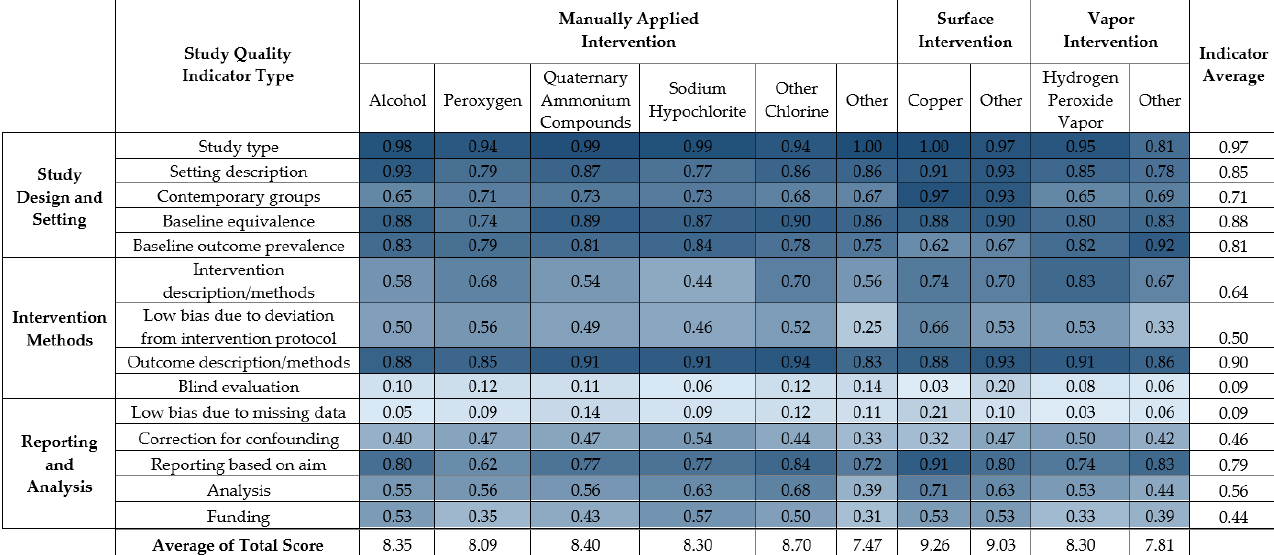
Figure 4. Average score for fourteen study quality indicators individually and in sum for each disinfection intervention type.